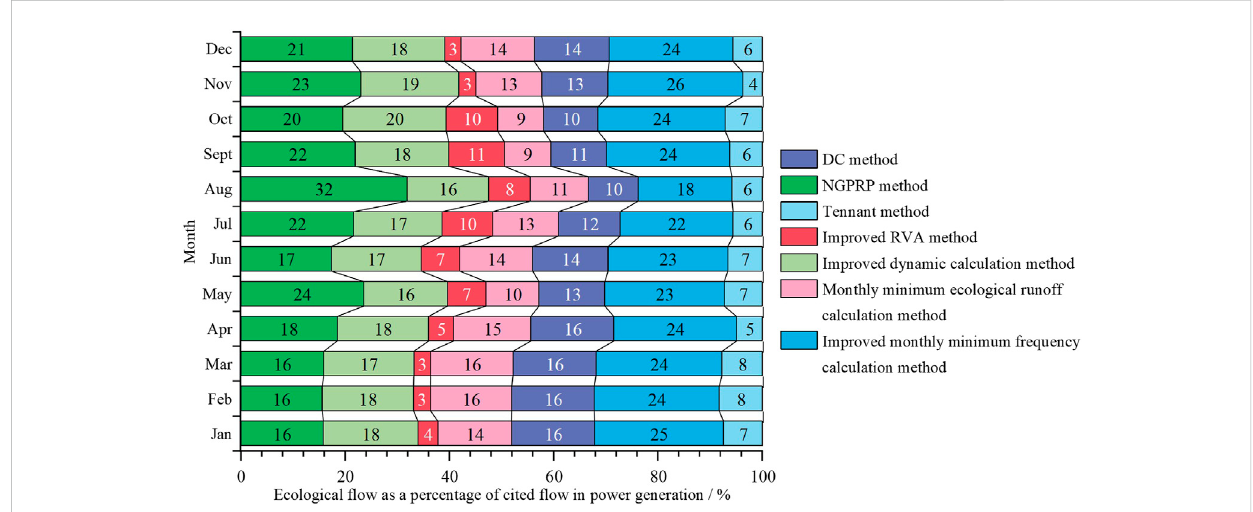
FIGURE 6 Percentage of monthly ecological fl ow in a generation diversion one within the